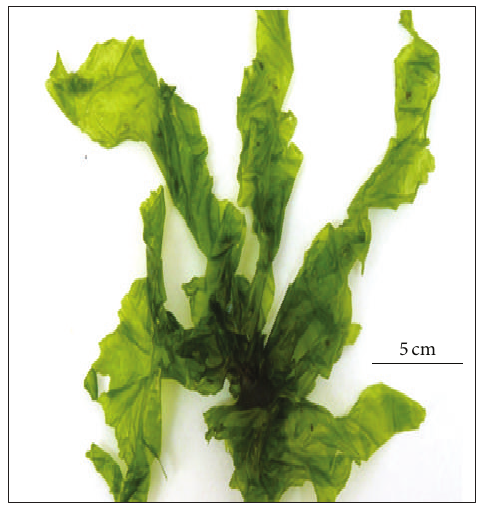
Figure 1: Collected marine macroalgal species Ulva